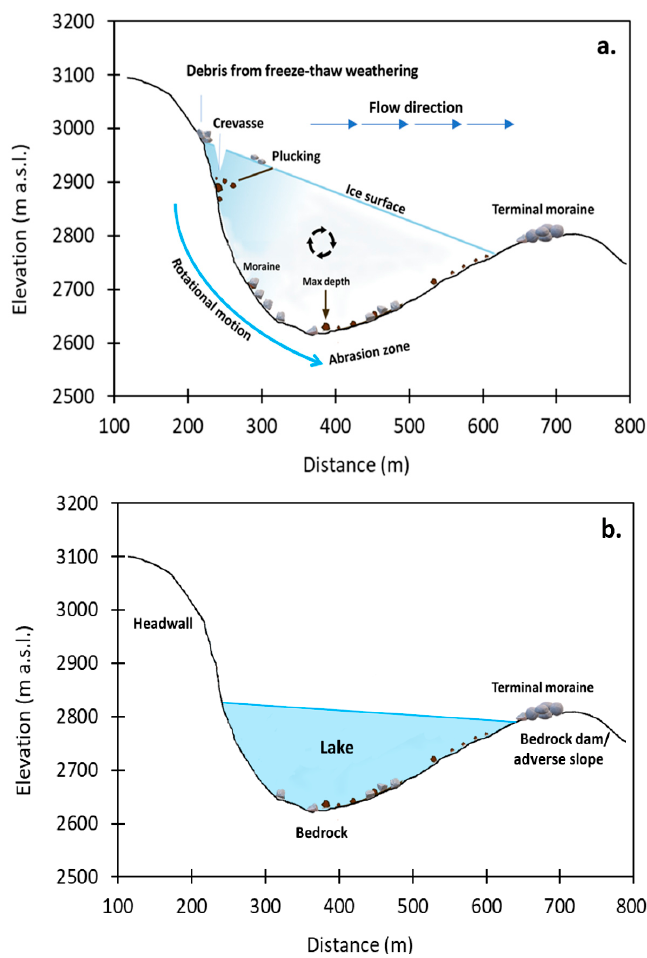
Figure 3. Two-dimensional cross-section of an overdeepening ( a ) and the process of lake formation after glacier retreat ( b ).